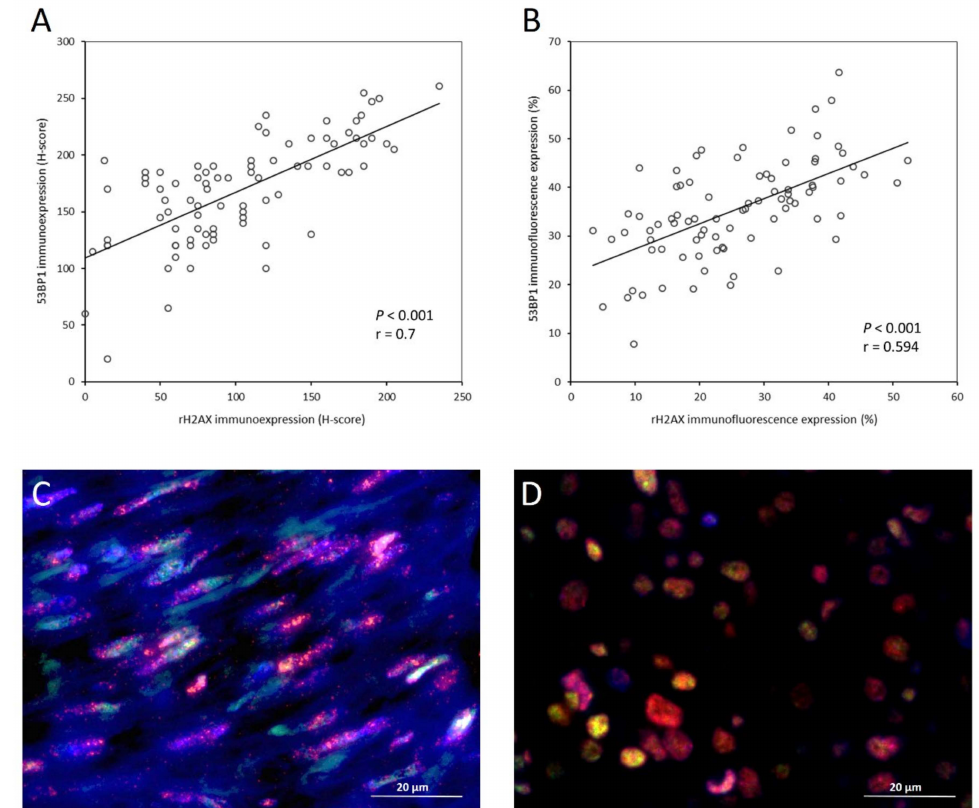
Figure 4. Strong associations between rH2AX and 53BP1 in expression levels and subcellular localization. The scatter plots of the H-scores of immunoexpression (( A ), p < 0.001, r = 0.700) and the percentages of immunofluorescence expression (( B ), p < 0.001, r = 0.594) both demonstrate strong correlations between rH2AX and 53BP1. Double immunofluorescence stains for rH2AX (red) and 53BP1 (green) with DAPI counterstaining (blue) in representative moderate-risk ( C ) and high-risk ( D ) GISTs showed granular yellow foci, indicative of colocalization, in the tumoral nuclei of the merged